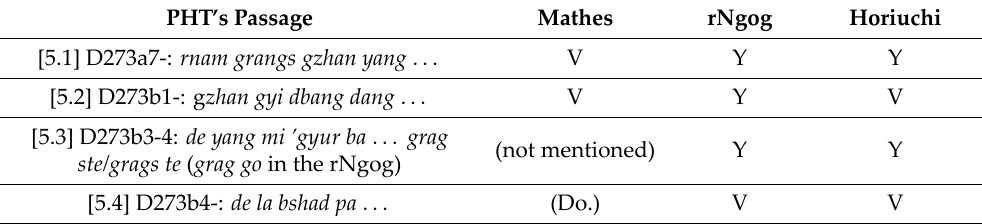
Table 1. Affiliations of statements in the